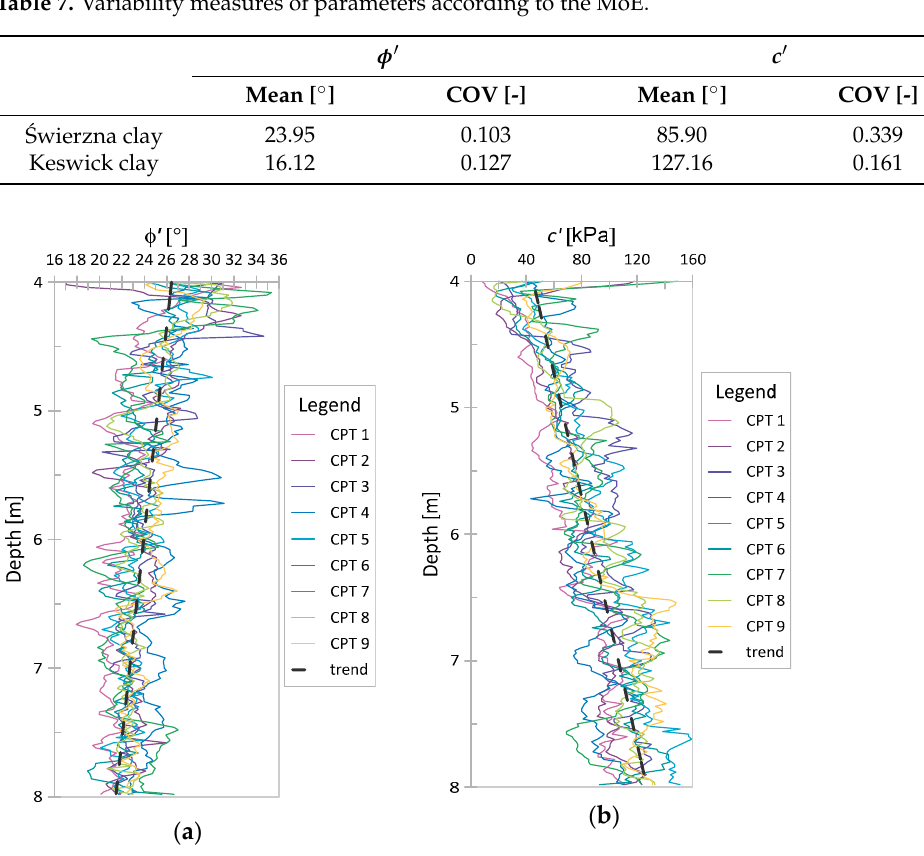
( a ) ( b ) Figure 13. MoE results for Keswick clay: ( a ) ϕ ′ ; ( b ) c ′ . Table 7. Variability measures of parameters according to the MoE. ϕ′